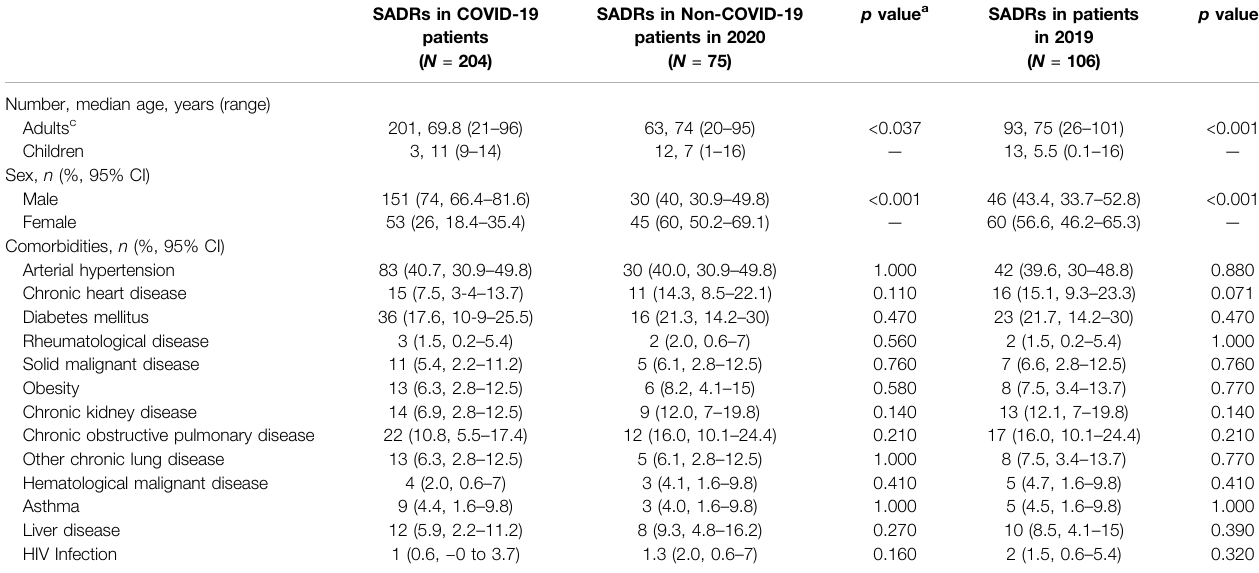
TABLE 4 | Characteristics of the patients who had SADRs during the study